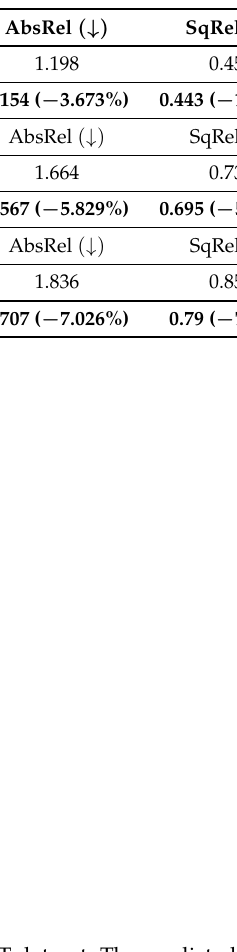
Table A2. Comparison of adapted and baseline depth estimation networks on RWFOREST 256 × 256, RWFOREST 512 × 256, and RWFOREST 1024 × 512.